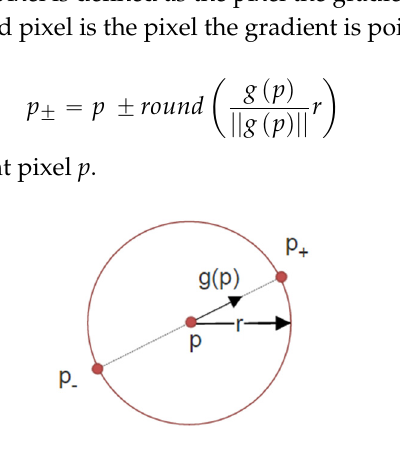
Figure 2. Eye region selection. ( a ) Cropped face image and vertical image projection (on the right). The local minima of the image projection are drawn with blue lines; and ( b ) the selected eye area (the green rectangle) and the estimated position of the eyebrow row (the red line).